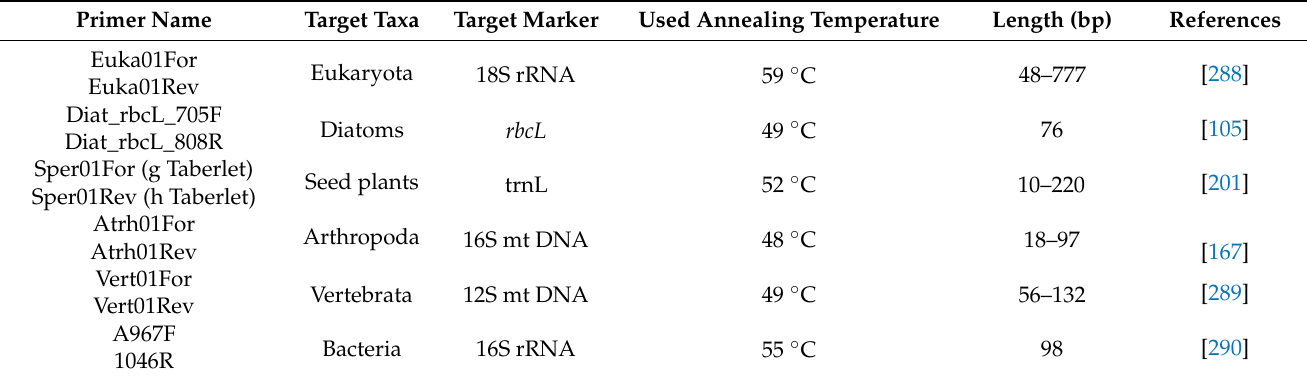
Figure A5. Overview of the extractions. In the graph a represents the intracellular and extracellular DNA extraction, and b the Andersen lysis buffer total DNA extraction. qPCR amplification—All qPCR reactions were done on the same qPCR machine (CFX96, BioRad). qPCR amplification was done in 10- µ L reaction volumes containing the following, 1X TATAA SYBR ® GrandMaster Min, 0.5 uM forward primer, 0.5 uM reverse primer (0.2 uM was used instead of 0.5 uM for the diatom primers). The thermocycling Table A7). The thermocycling program was as follows, 30 s at 95 ◦ C, followed by 60 cycles of 5 s at 95 °C, 30 s annealing (48–59 °C), and 10 s at 72 °C. After the qPCR cycles a melting every 5 s. Table A7. Summary of the markers and the used primers and annealing temperatures used for the qPCR amplification.